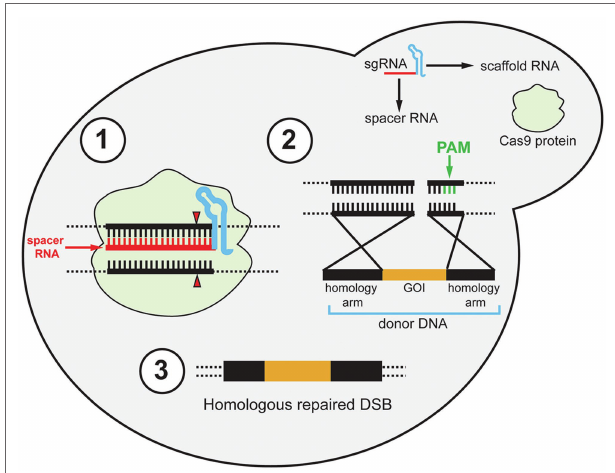
FIGURE 1 | Schematic diagram of the CRISPR/Cas9 mechanism in yeast. The single gRNA (sgRNA) contains two components: scaffold RNA (tracrRNA and structural part of crRNA) and a 20-nt spacer RNA. (1) After the Cas9 protein binds to the sgRNA, Cas9 binds to the target sites in the genomic DNA and undergoes conformational change to cut both strands of the target site 3-bp upstream of the PAM site (red triangle). PAM site is shown in step 2. (2) After a double-stranded break (DSB) is induced, the preferable homology- directed repair (HDR) mechanism repairs the DSB using donor DNA. The donor DNA contains 5 ' and 3 ' homology arms and a gene of interest (GOI). The GOI can be non-functional for gene deletion purposes. Note that although the PAM site is emphasized in the second step (green bars), the PAM site is required for Cas9-gRNA complex to recognize the target sites in the first step. (3) After HDR, the DSB is repaired and the GOI is